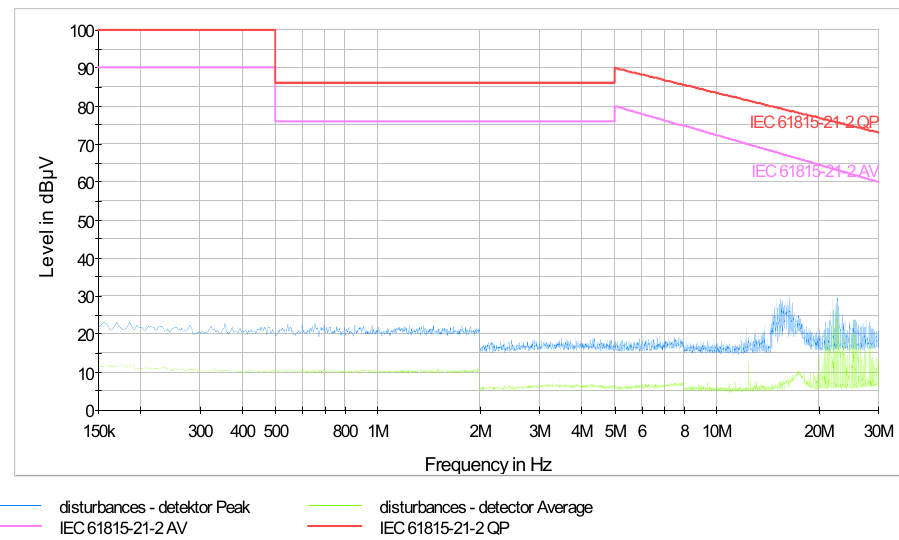
Figure 10. Conductive disturbances of the charging station, AC module operation (80% power), IEC 61851-21-2 limits for average (AV) and quasipeak detectors (QP); blue line—disturbance level measured by the peak detector, green line—disturbance level measured by the average detector.